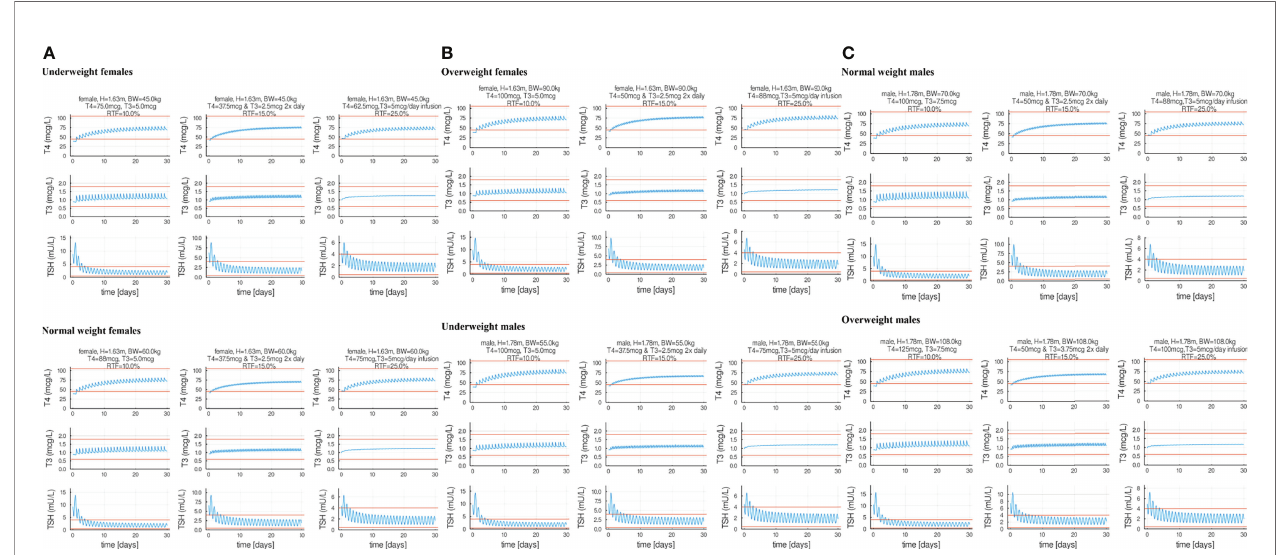
FIGURE 6 | Eighteen combination therapy p-THYROSIM simulations for different residual thyroid function (RTF) values, representing averages of the RTF range computations in reference (26). Each row features a male or a female patient receiving a single LT4 + LT3 combination dose per day (left), two separate LT4 + LT3 combination doses 2× per day (center) and 1× dose of T4 per day combined with constant (ideal therapy) T3 infusion (right). Panel (A) includes underweight and normal weight female patients. Panel (B) includes overweight female patients and normal weight male patients. Panel (C) includes normal and overweight male